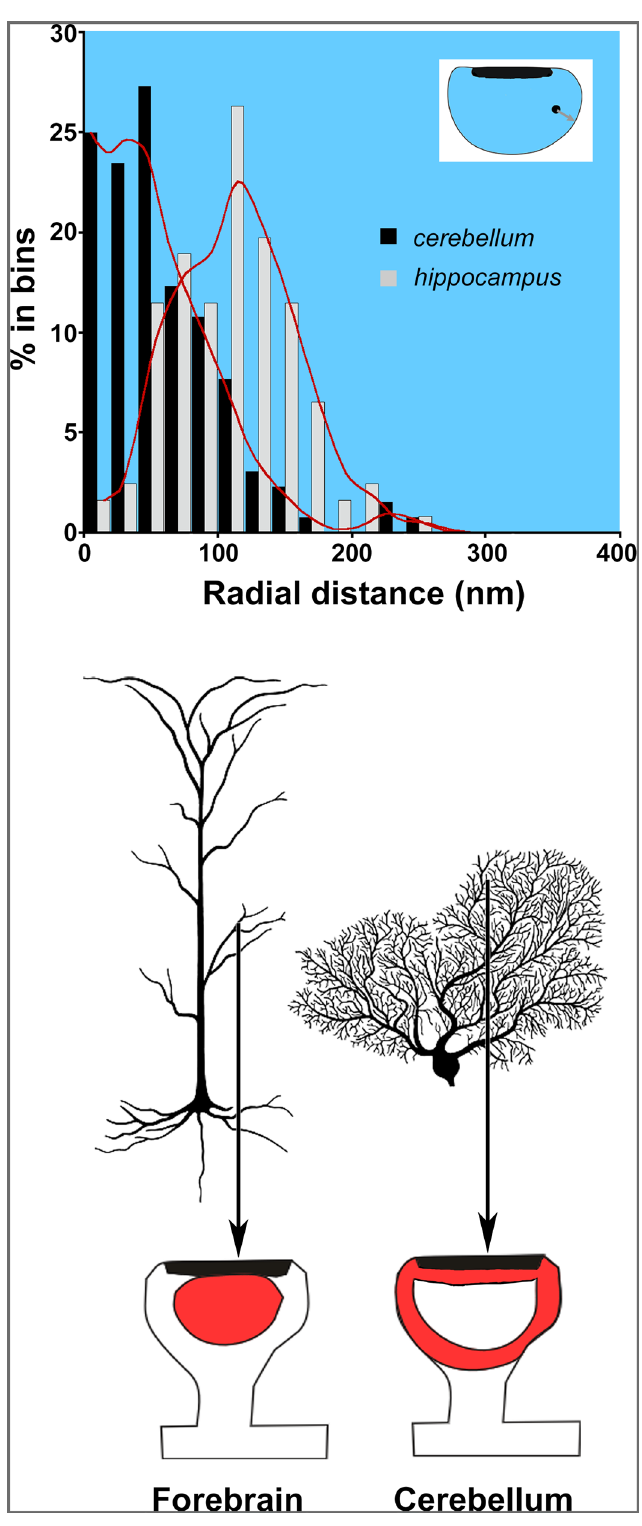
Figure 6. Different distribution of cortactin within forebrain, and cerebellar spines. Upper panel: graph showing the radial distribution of gold particles coding for cortactin in hippocampus (gray columns, data is from 25 ), and cerebellum (black columns). Cortactin accumulates in the core of hippocampal spines, while it resides in the shell in PCs (see inset for explanation of radial distributing particles; red lines are trend representations of the bar values as smoothed curves). Lower panel: schematic figure showing that cortactin in spines from apical dendrites of forebrain pyramidal neurons concentrates in a central, spinoplasmic core region, while PC spines have a shell-enriched cortactin